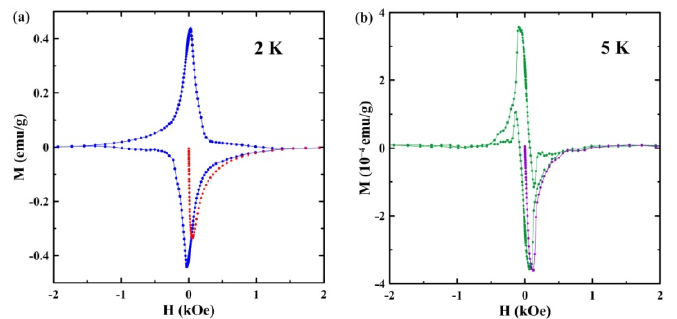
Figure 5. ( a ) Temperature dependencies of the FCC, FCW, and ZFC susceptibilities at 100 Oe near the superconducting transitions. The inset shows the total ZFC and FCC curves. ( b ) Temperature dependencies of the FCC (solid lines) and FCW (dashed lines) susceptibilities near the supercon- ducting transitions at fields indicated in the panel. The arrows show the direction of changing temperature.